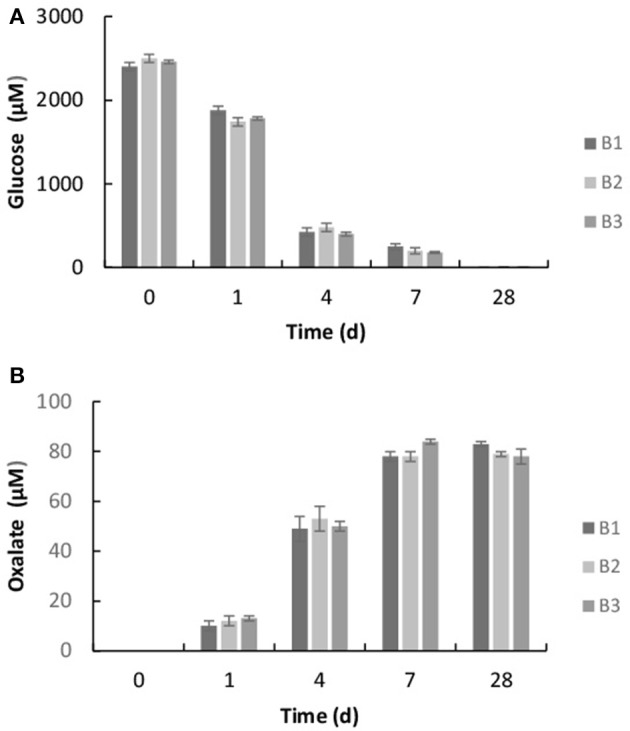
Concentration of glucose (A) and oxalic acid (B) in the growth medium after 1, 4, 7, and 28 days. The values reported are the means of three independent experiments, and the standard error associated with these determinations is shown.